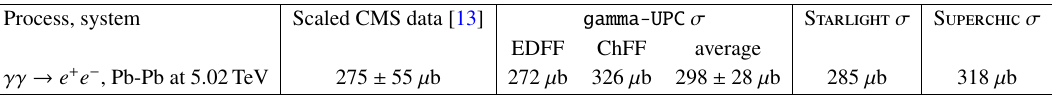
Table 12 . Fiducial exclusive dielectron cross sections measured in Pb-Pb UPCs at 2 GeV , j y e j < 2 : 4, m e + e (cid:0) > 5 GeV, p T ; e + e (cid:0) < 1 GeV), compared to the theoretical gamma-UPC results